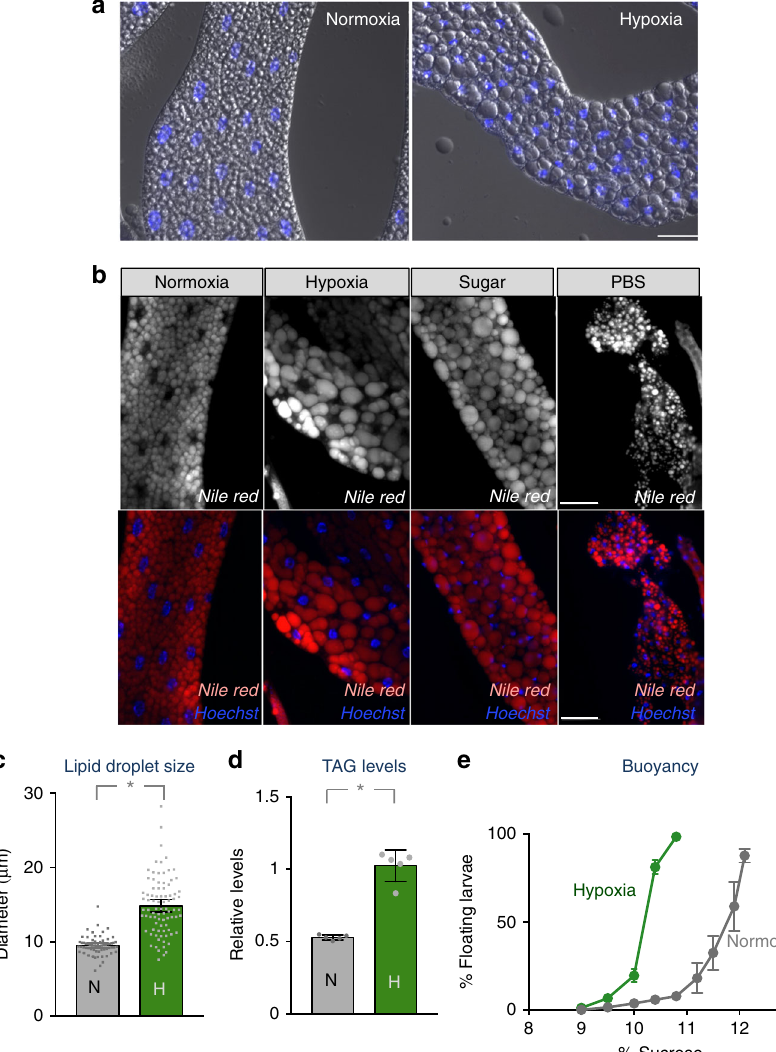
Fig. 6 Hypoxia alters lipid levels and lipid storage. a Larvae were hatched in normoxia and then maintained throughout the larval period in either normoxic or hypoxic conditions. Fat bodies from third instar larvae were then imaged using DIC microscopy. Blue = Hoechst DNA stain. Hypoxia led to an increase in lipid droplet size in fat body cells. Scale bar = 50 μ m b w 1118 larvae were grown in normoxia until 72 h after egg laying at which point they were